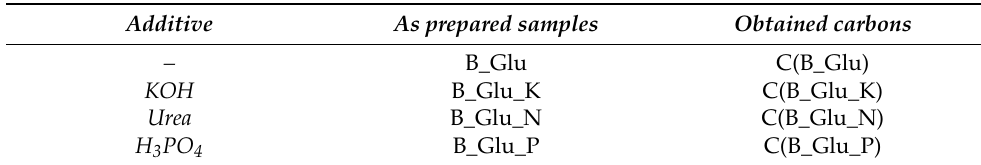
Table 6. Nomenclature of the synthesized samples.